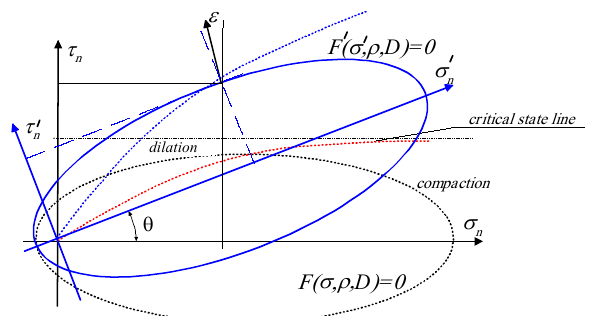
Figure 9: Change of the failure surface position by rotation through an angle